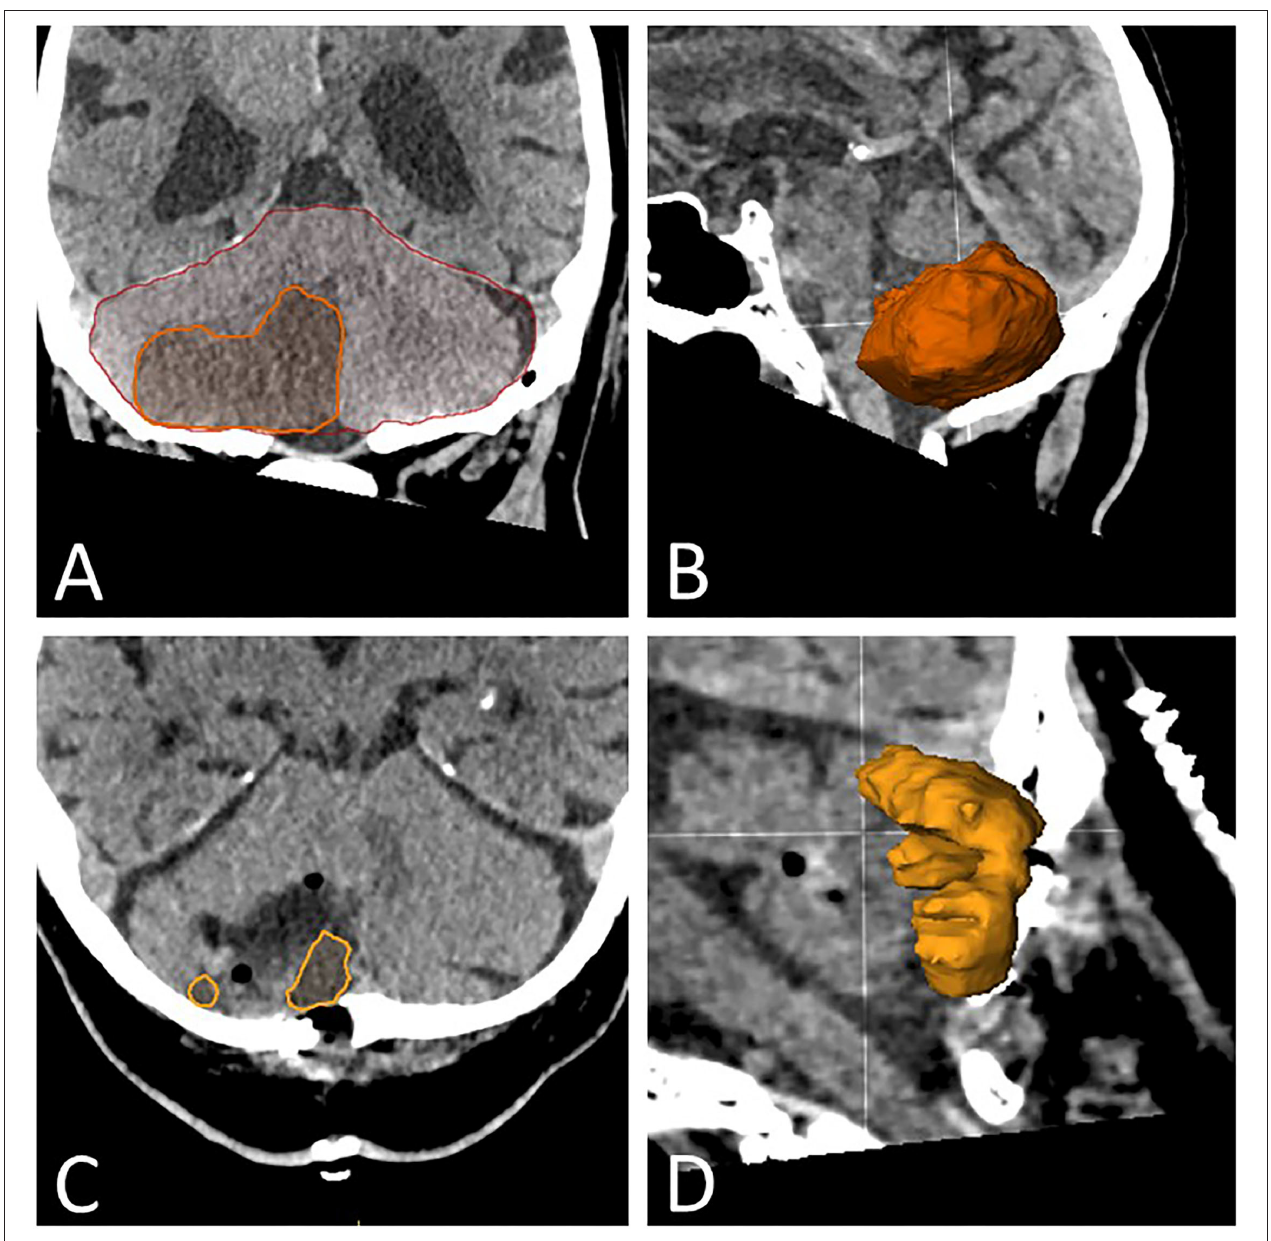
FIGURE 1 | Volumetric analysis. (A) CT image of the cerebellum in the coronal plane depicting the segmentation of the posterior cranial fossa (red line) and of the infarcted area (yellow line). The segmentation is performed in the coronal, sagittal, and axial planes and adjusted accordingly for each slice if necessary. (B) Three-dimensional depiction of the cerebellar infarction for illustration purposes. (C) CT image of the cerebellum in the axial plane, with segmentation of residual infarction after necrosectomy (inside yellow line). (D) Three-dimensional depiction of the residual cerebellar infarction for illustration